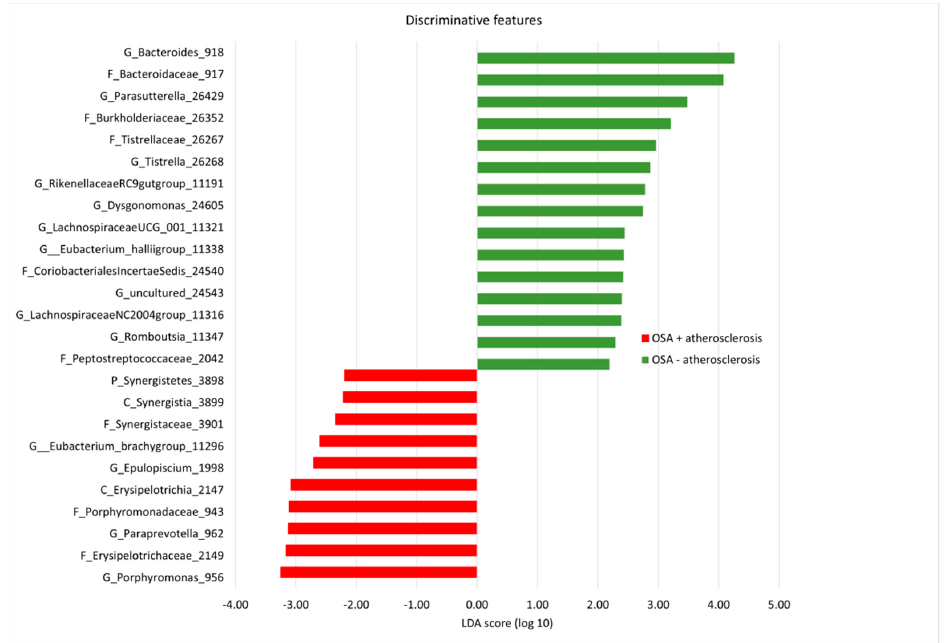
Figure 1. Discriminant features between the two groups based on the LEfSe method. Red bars represent taxa more abundant in the atherosclerotic group, green bars represent taxa more abundant in the non-atherosclerotic group.